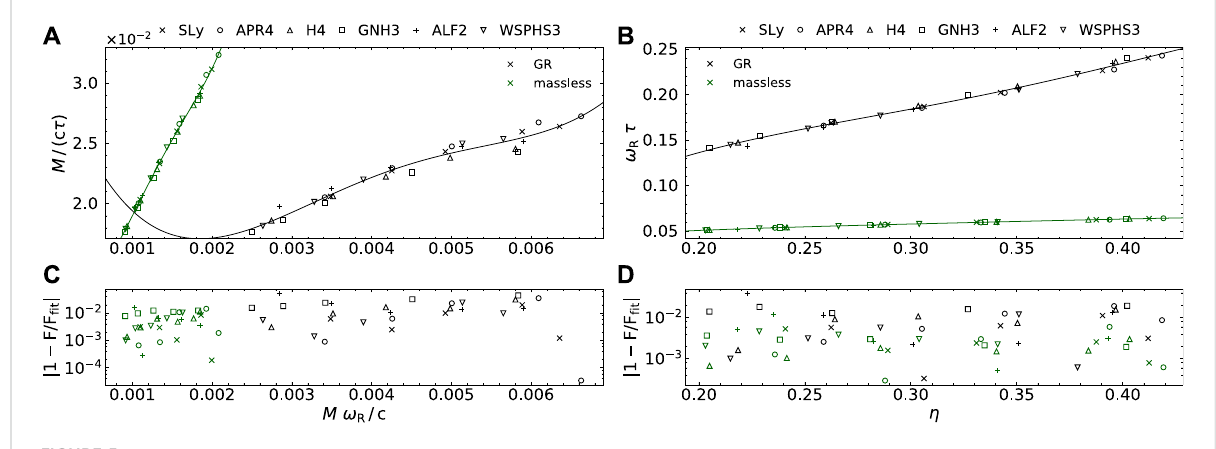
FIGURE 5 Quadrupole ϕ -mode universal relations: dimensionless inverse damping time M /( c τ ) versus dimensionless frequency M ω R / c (A) and fi t errors (C) ; dimensionless product ω R τ of frequency and damping time versus generalized compactness η (B) and fi t errors (D) . The symbols indicate the respective equation of state. The massless scalar – tensor case is shown in green, and the general relativistic case is shown in black.